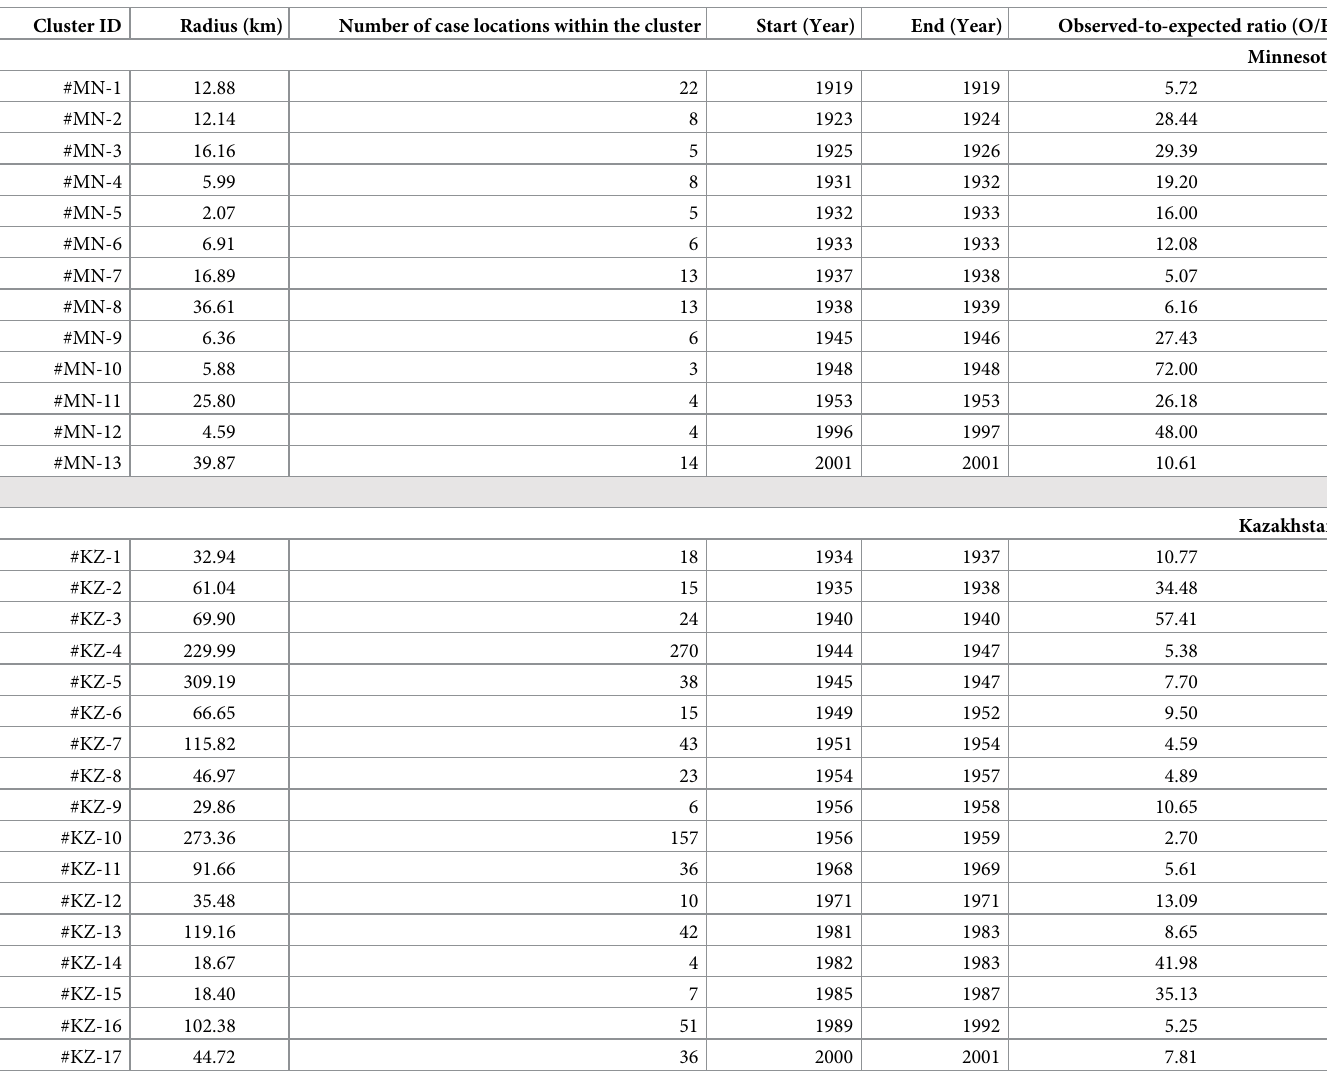
Table 1. Summary of spatiotemporal clusters of Anthrax detected in Minnesota (between 1912 and 2014) and Kazakhstan (between 1933 and 2014), using the spa- tiotemporal permutation model of the scan statistics. The spatial and temporal windows of the scan statistic were set to 10% and 5%